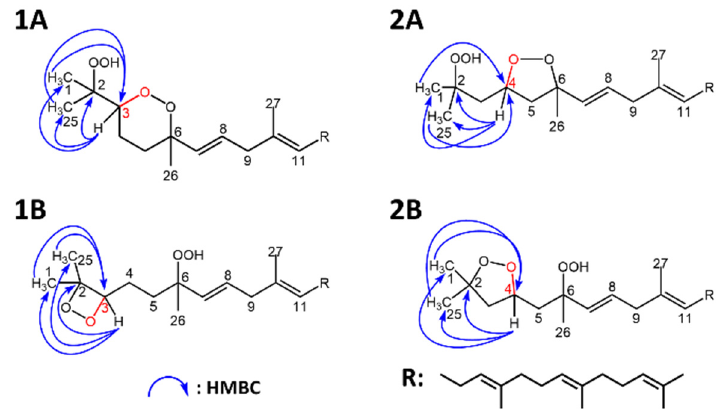
Figure 4. Candidate structures of SQ secondary oxidation product and their heteronuclear single quantum coherence (HMBC) correlations. ( 1A , 1B ), based on the correlations of H1 and H25 to C3, and H3 to C1, C2 and C25; ( 2A , 2B ), based on the correlations of H1 and H25 to C4, and H4 to C1, C2 and C25.